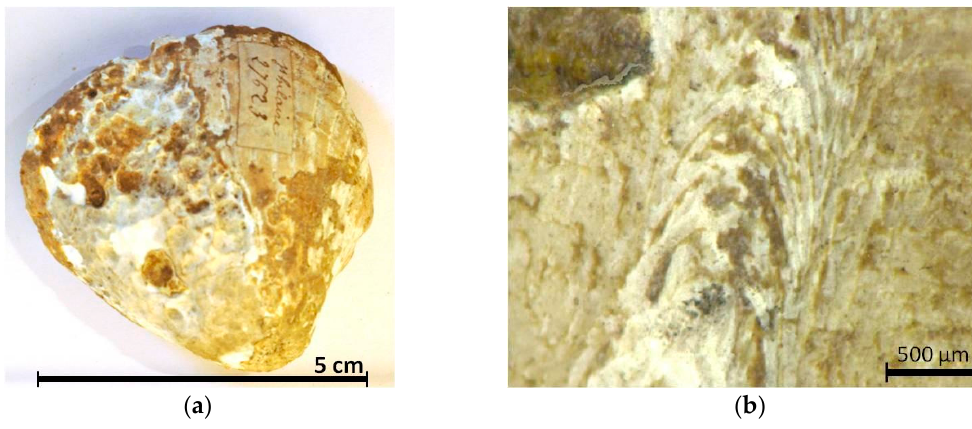
Figure 12. Iron Age shell from Saint-Hilaire-le-Grand in the Champagne region in France ( a ) and a microscopic image ( b ) of the structural features.